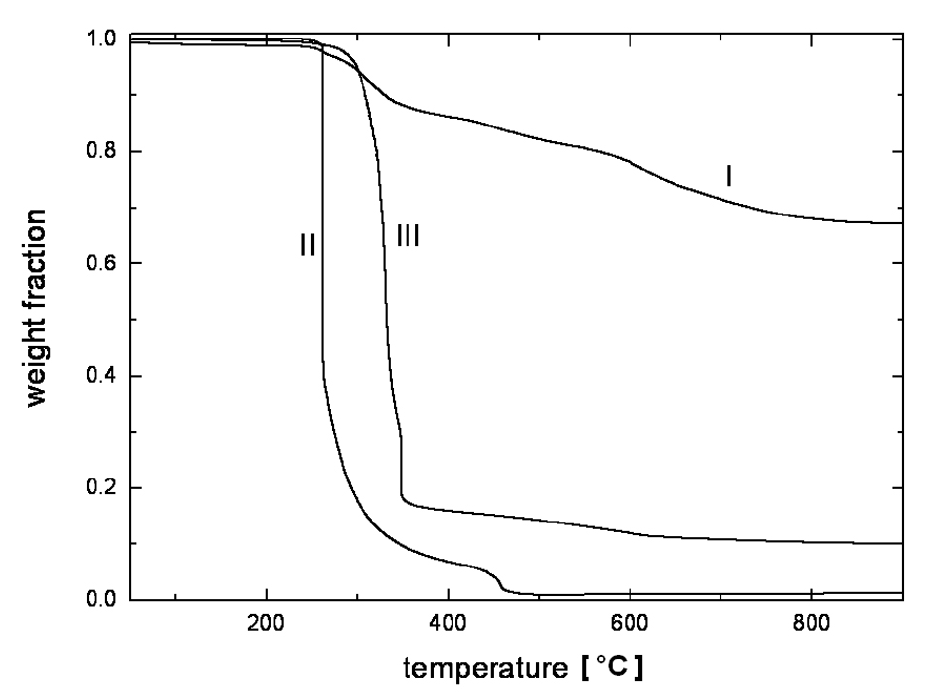
Figure 13. TGA thermograms of the (I) modified clay, (II) pure PP and (III) 4 vol% PP-OMMT composite. Reproduced from reference [50] with permission from